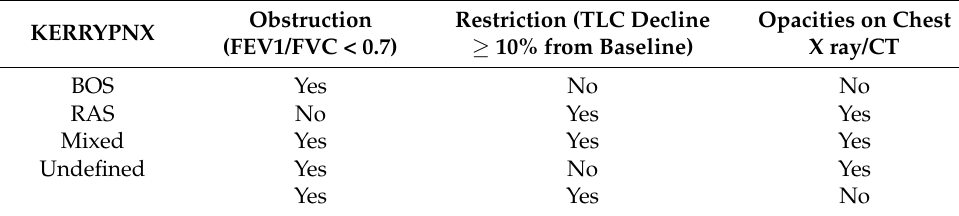
Table 3. CLAD phenotypes (from